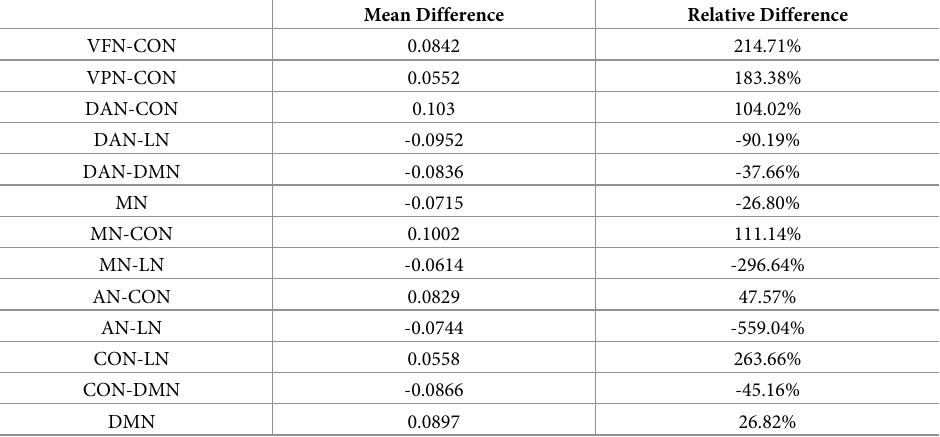
Table 3. Significant differences in brain connectivity matrices are located mostly in the below subnetworks. Mean Difference: